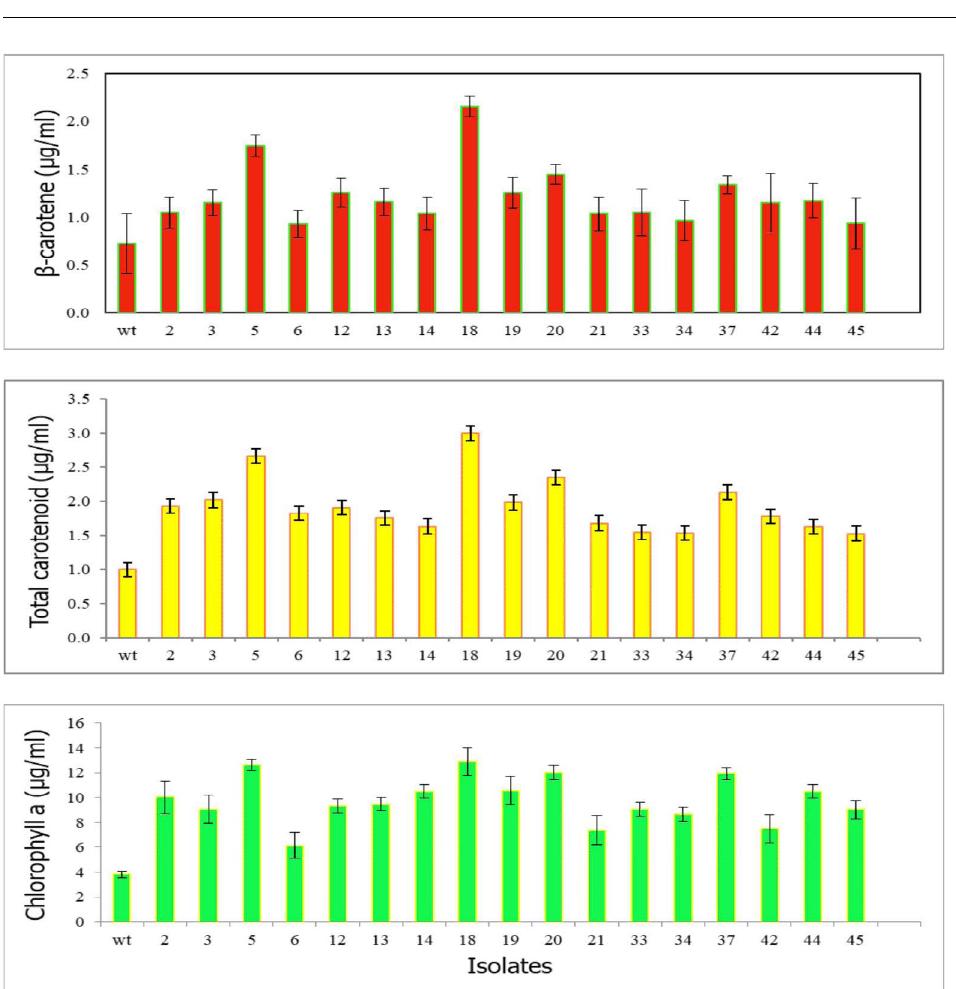
Fig. 4. Pigment concentrations of 17 selected survival mutants grown in modified Johnson’s medium under light intensity 200 mmol photons m -2 ·s -1 at 12 th day of cultivation